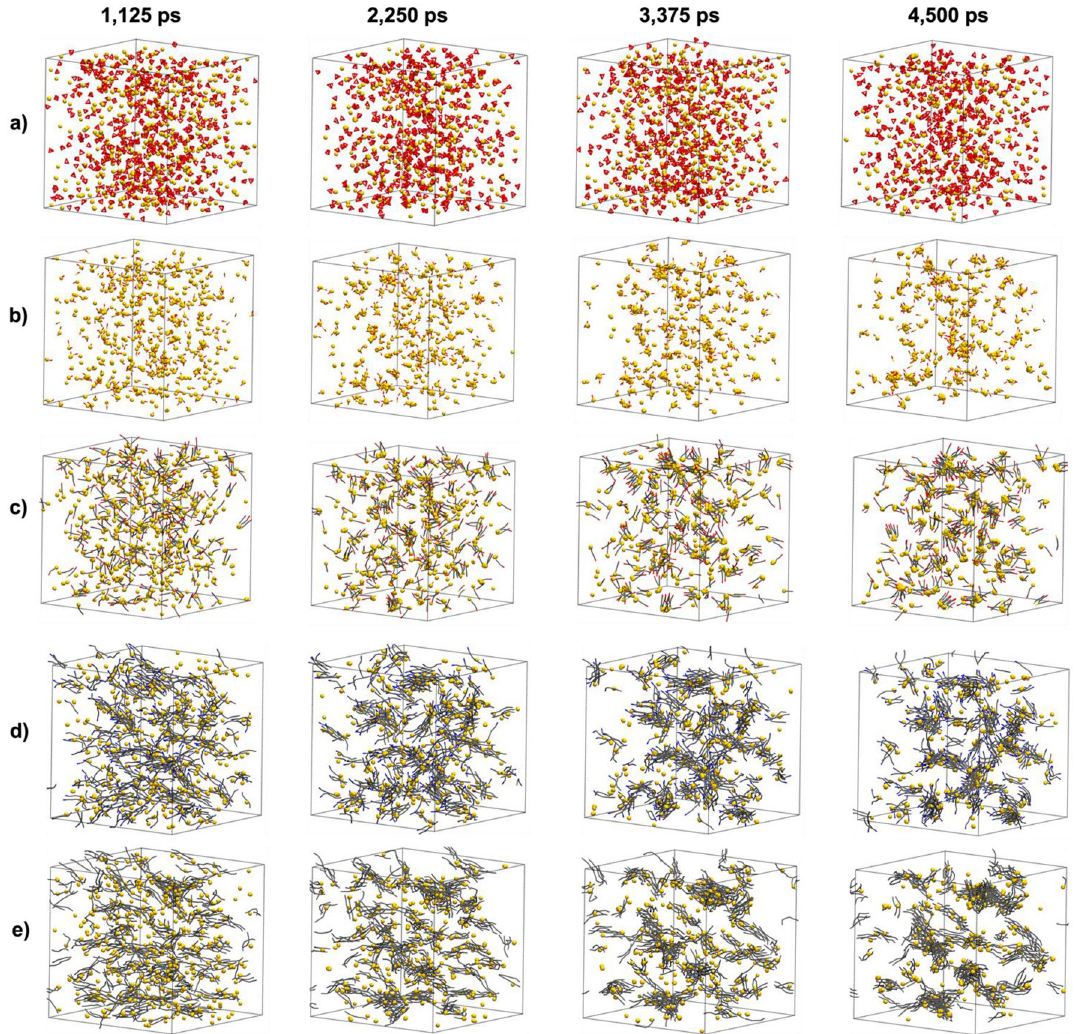
Figure 2. Snapshots taken at 1125, 2250, 3375 and 4500 ps. ( a ) O-type/Au. ( b ) S-short/Au. ( c ) S-long/Au. ( d ) N-type/Au. ( e ) C-type/Au. Gold beads were represented in CPK of drawing method, while surfactants were drawn with Licore method. Waters were removed and all surfactant bond radius were reduced for